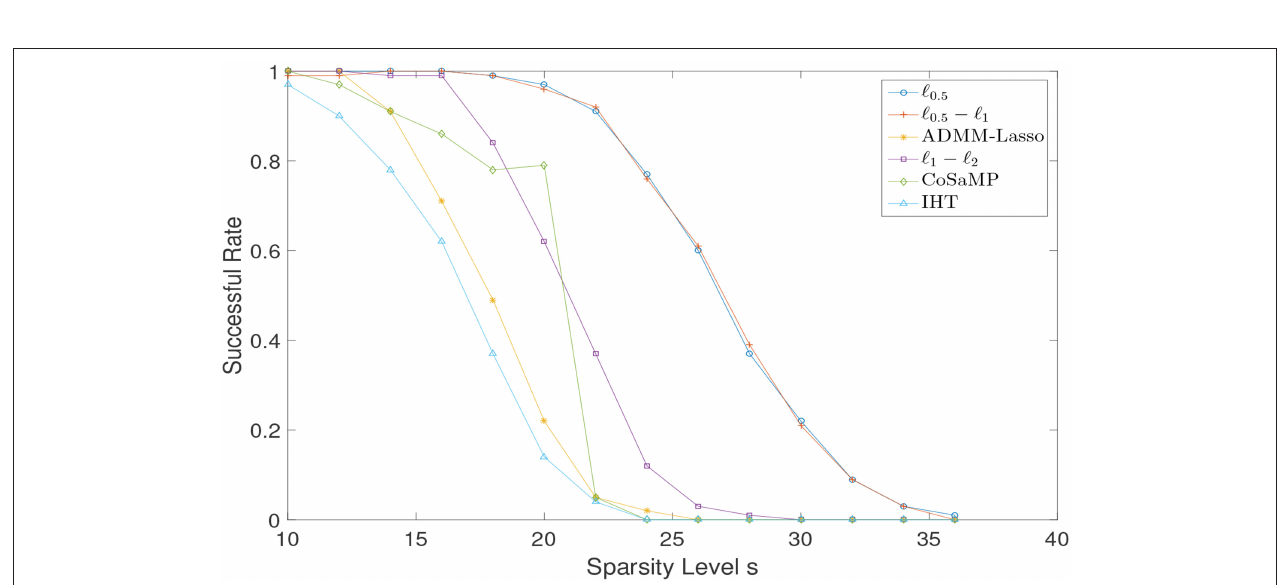
FIGURE 6 | Sparse signal recovery performance comparison via different algorithms for Gaussian random